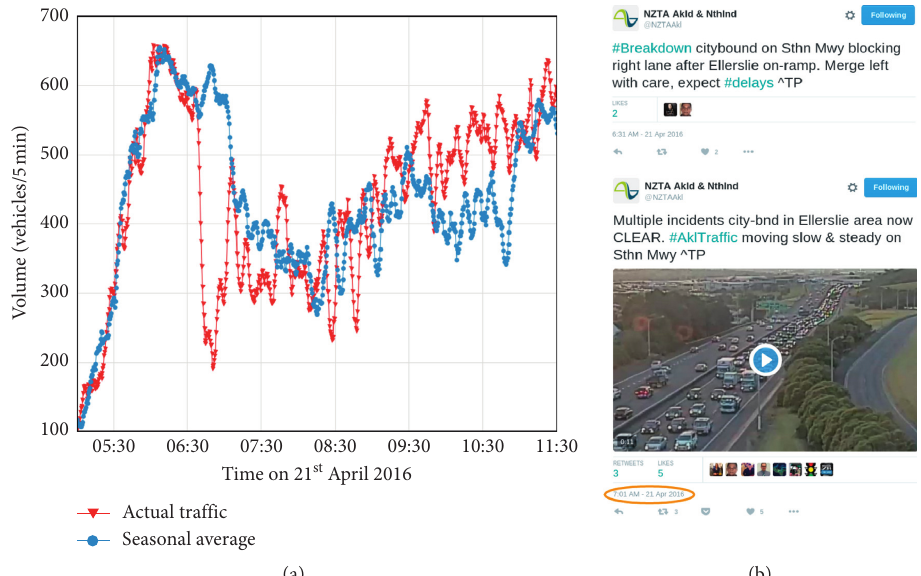
Figure 4: (a) Traffic volume in segment 23 on April 21, 2016, (Thursday) compared with the historical weekly average and (b) tweets from NZTA accessed from [57] on April 21,